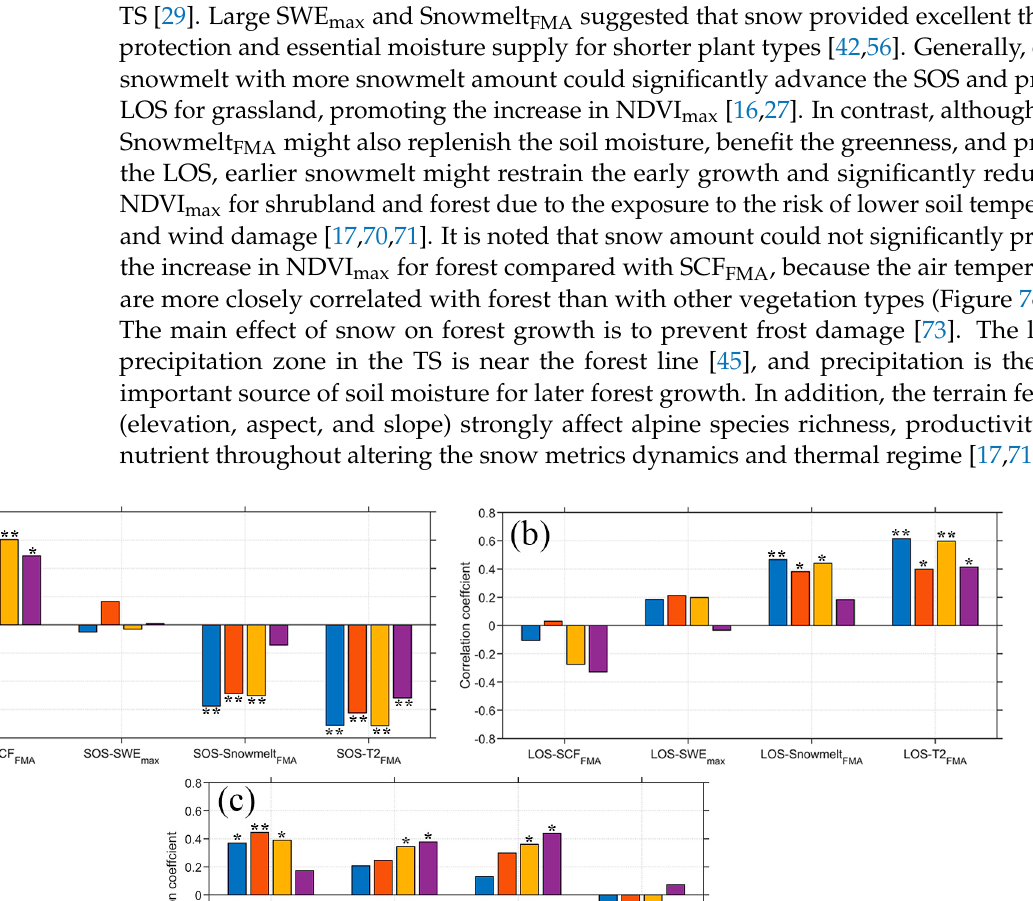
Figure 8. Elevation variation of correlation coefficients between ( a ) SOS, ( b ) LOS, and ( c ) NDVI max and SCF FMA , SWE max , and Snowmelt FMA for grassland and sparse vegetation. 4.3. Limitations and Uncertainties The performance of the snow dataset generated by a regional model depends on the forcing data accuracy, physical schemes and model parameterizations, and spatial reso- lution [43,74]. A cold bias, precipitation overestimation, and lack of data assimilation caused a large uncertainty of snow simulation in the high-elevation regions, particularly in the snow ablation period [37,75]. In addition, the spatial heterogeneity of snow could not be revealed in the complex terrains using a relatively coarse resolution (9 km) [76,77]. Similarly, the spatial resolution of GIMMS NDVI 3g is appropriate for landscape-scale research, but maybe not be sufficient for specific species or plant communities at a finer scale [17,78]. The synergistic analysis from the higher remote sensing data (such as MODIS, Landsat, Sentinel-2, Gaofen, and digital cameras) may provide a feasible way to investigate relationships between snow cover and vegetation and their interactions under